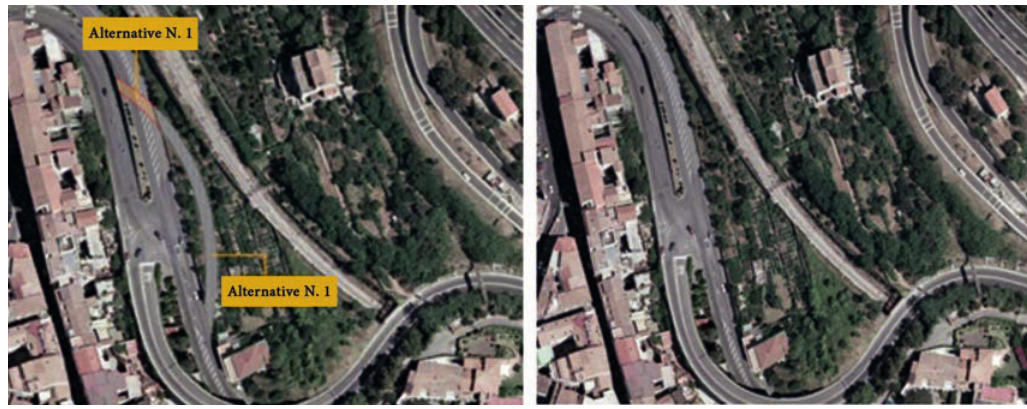
Fig. 4. The area and alternative photogram